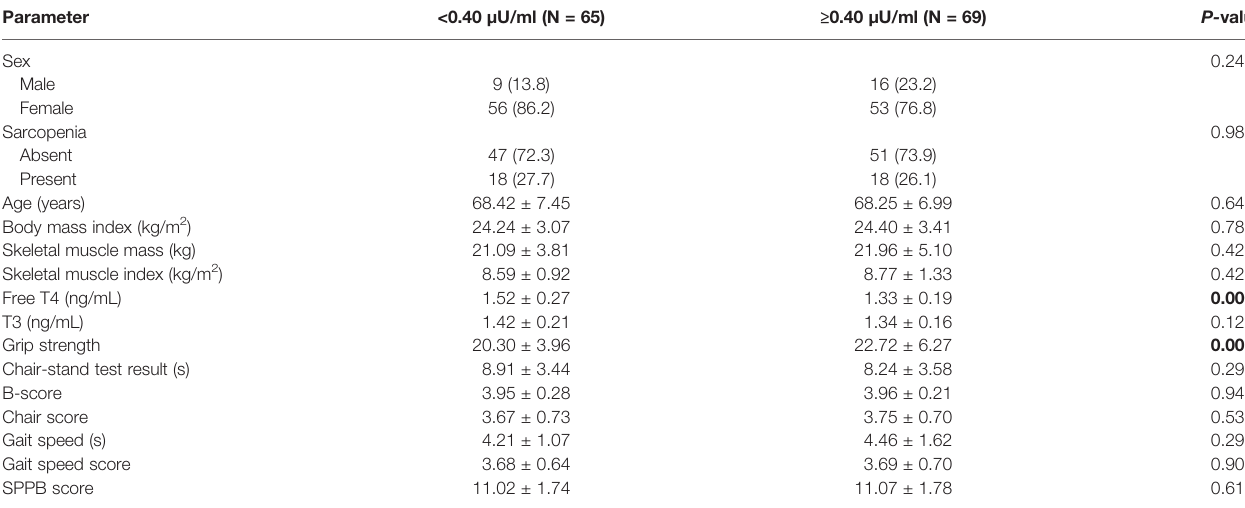
TABLE 2 | Clinical characteristics of the study sample, categorized according to serum TSH concentration (N = 134). Parameter